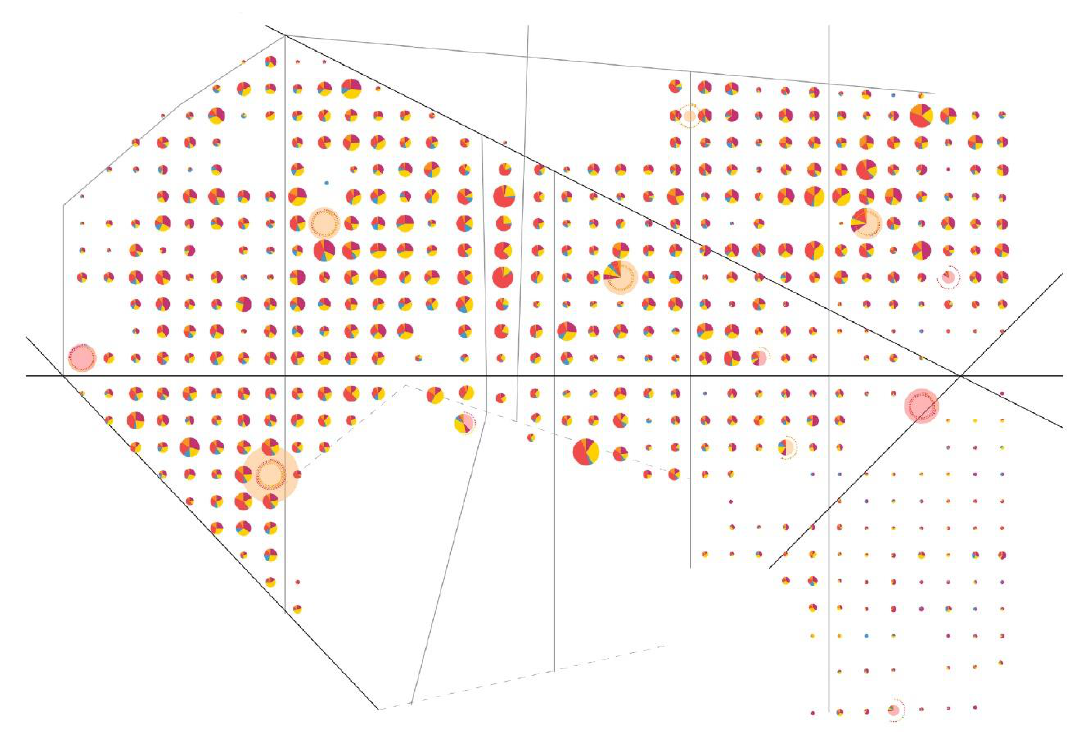
Figure 9. Activities mixture by blocks in the Eixample. Representation of the amount of activity units of each group through pie chart. Considerations: (1) the size of the circle depends on the total count of activities; (2) in markets and shopping centers (as considered by the Economic activities census), the activity count is made in perimeter dots; (3) if a pie chart is overlaid, it only represents activities of the block that are not part of the market or shopping center; and (4) blocks containing only public facilities are not shown. The main city axes overlapped.